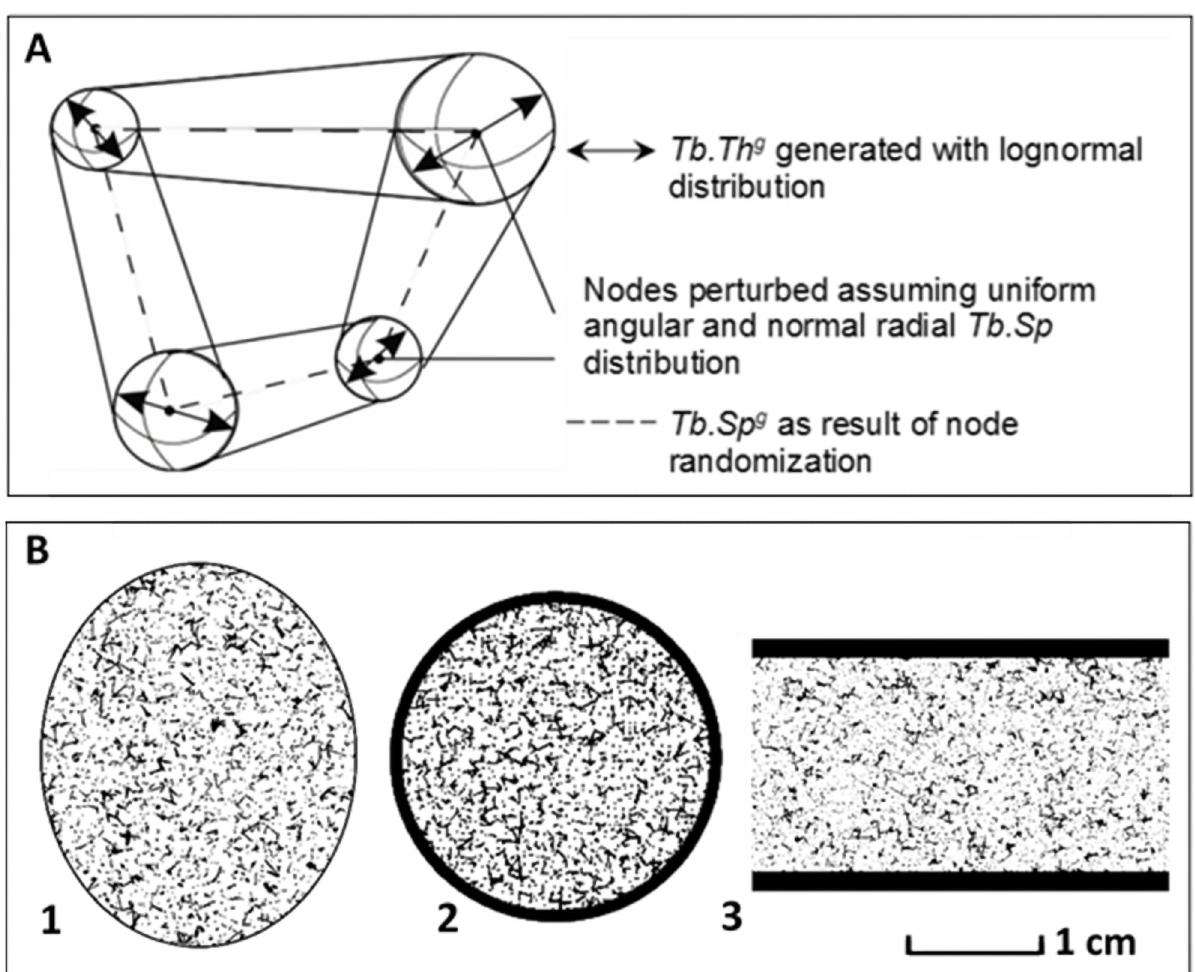
Fig 4. Model examples of the generated trabecular structures. (A) Scheme of four interconnected trabeculae and randomization of the grid and simulation of Tb . Th g and Tb . Sp g ( g indicates the generated output against the original input data). (B) Cross-sections of the voxelized models for three bone segments with different micro-parameters and cortical thickness (bone is black-colored and marrow is white-colored). (1) Thoracic vertebrae body in age = 10 y ( Ct . Th = 0.2 mm; Tb . Th = 0.12 mm; BV/TV = 0.13); (2) Femur lower proximal end in age = 5 y ( Ct . Th = 1.3 mm; Tb . Th = 0.24 mm; BV/TV = 0.35); (3) Iliac dorsal segment equal for adult male and female ( Ct . Th = 1.5 mm; Tb . Th = 0.1 mm; BV/TV =